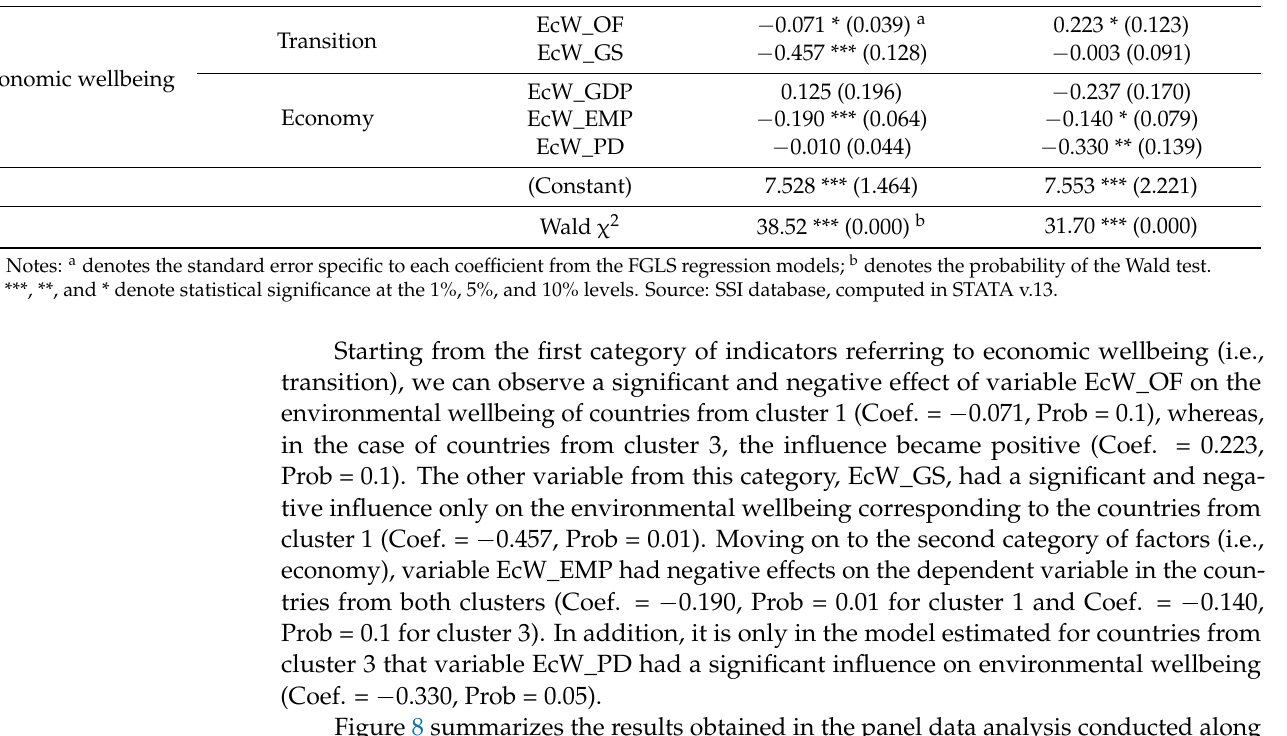
Table 6. Relations between environmental wellbeing and the components of economic wellbeing in clusters 1 and 3.